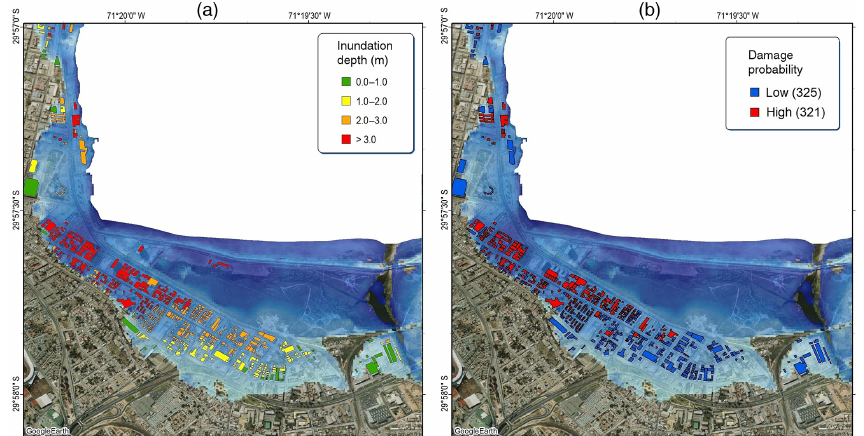
Figure 13. (a) Tsunami inundation map and inundation depth on structures. (b) Tsunami inundation map and low and high probabilities of damage to the flooded